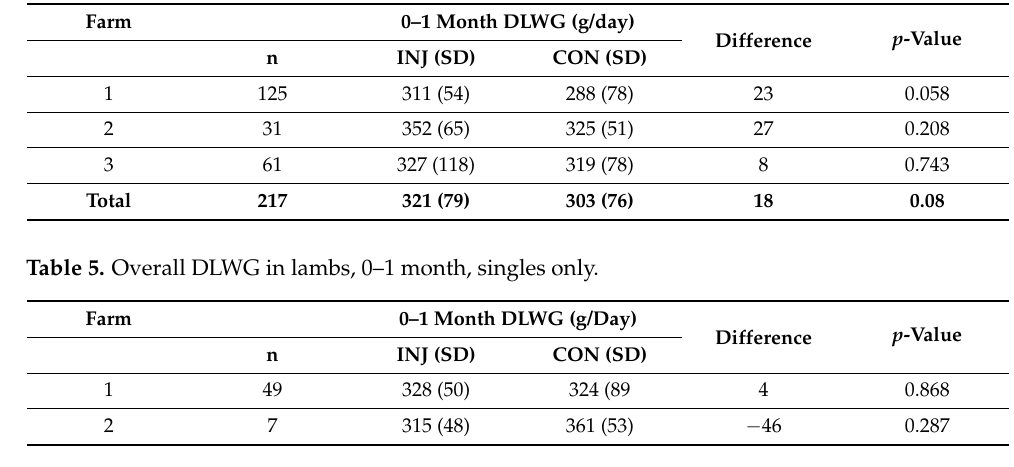
Table 4. Overall DLWG in lambs between 0–1 month.